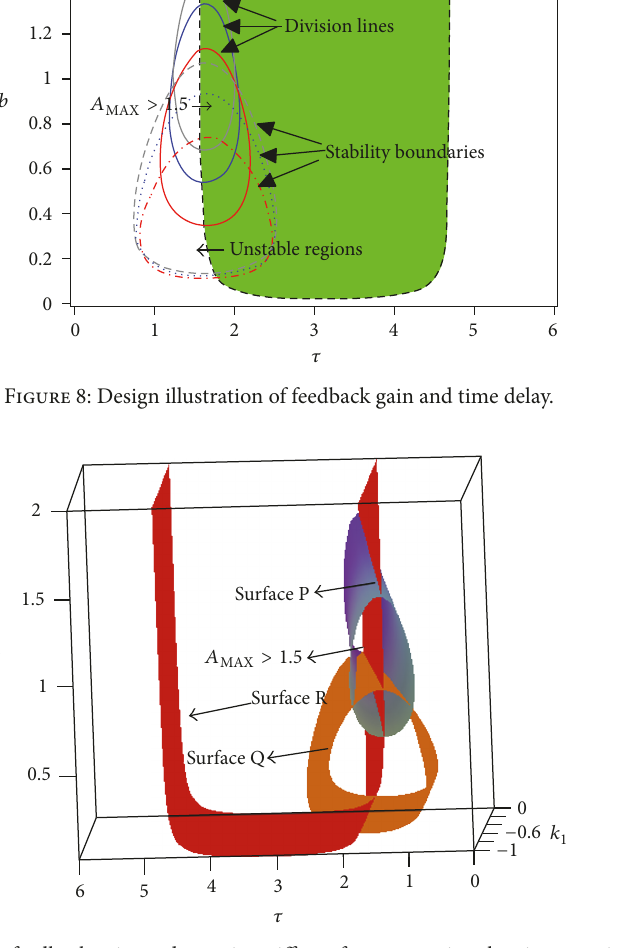
Figure 9: The relations of time delay, feedback gain, and negative stiffness for suppressing the given maximum displacement amplitude.